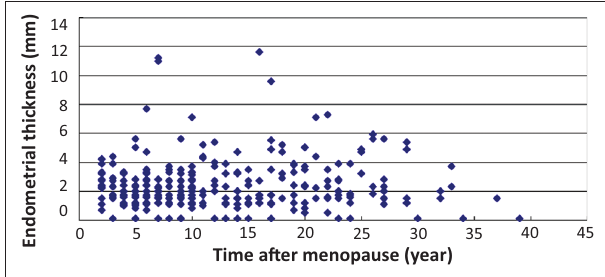
FIGURE 3: Endometrial thickness of 297 postmenopausal women. FIGURE 4: Relationship between endometrial thickness and time after menopause in 297 postmenopausal